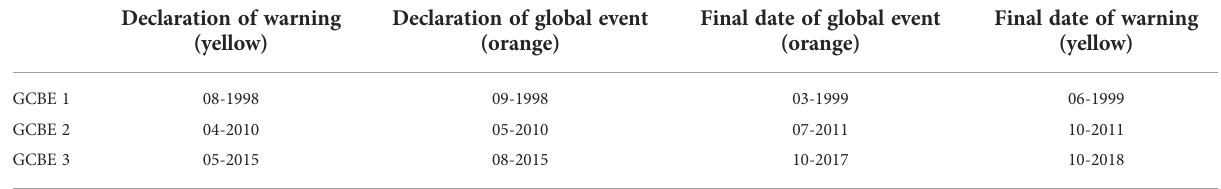
TABLE 2 Dates for declaration of global coral bleaching warning (yellow bars in Figure 3 ) and event (orange bars in Figure 3 ) using the 8-month detection window applied to the 5-km CoralTemp dataset for each Global Coral Bleaching Event. Declaration of warning Declaration of global event Final date of global event (yellow) (orange) (orange)